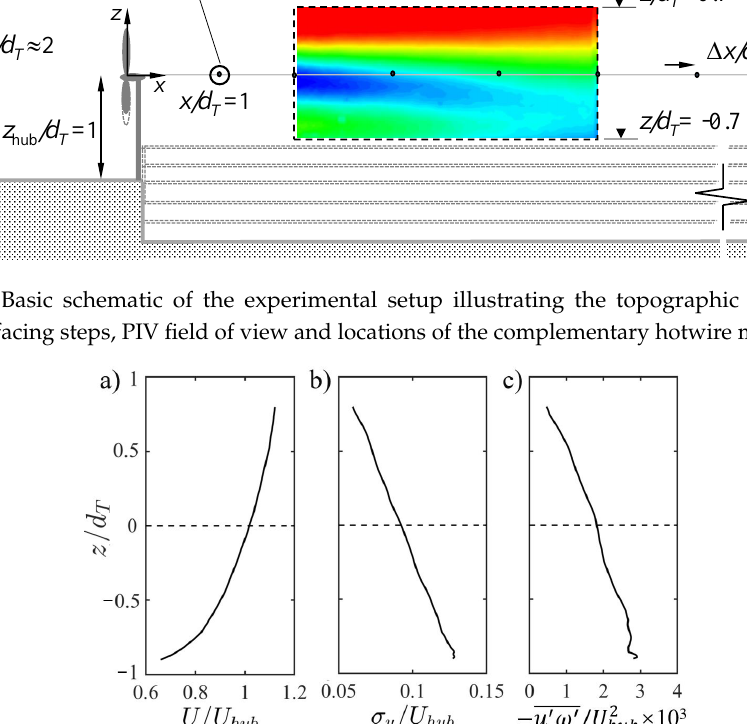
. The horizontal hub